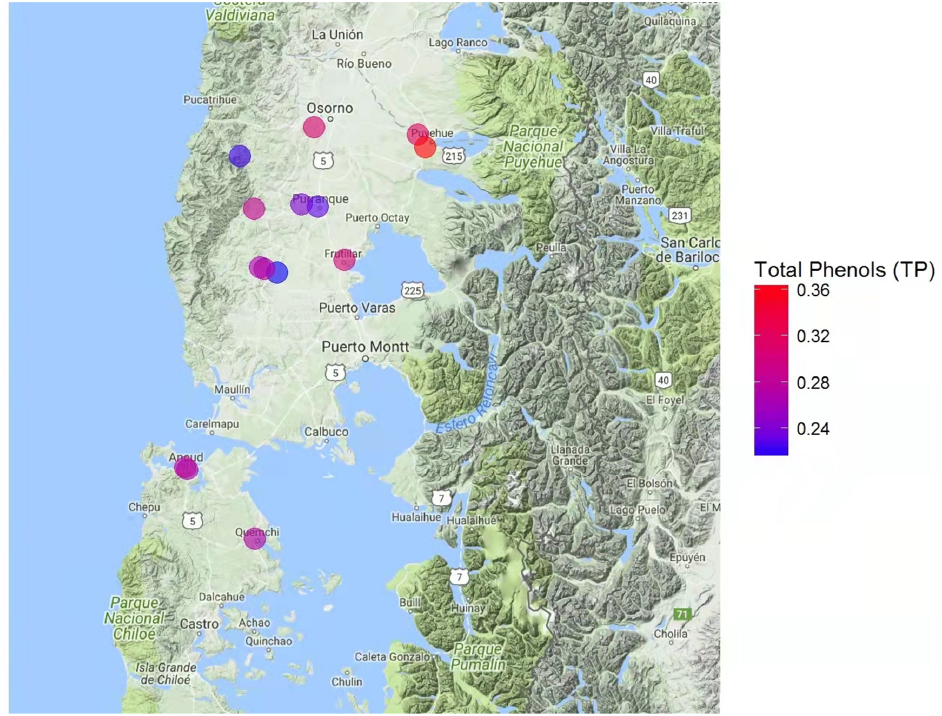
Figure 1. Map of the Los Lagos Region (Chile, 39 ◦ 16 (cid:48) S to 44 ◦ 04 (cid:48) S) indicating the sampled hive locations and respective phenol contents in honey samples. Contents concentration is indicated by a color scale going from blue (lower contents) to red (higher contents).